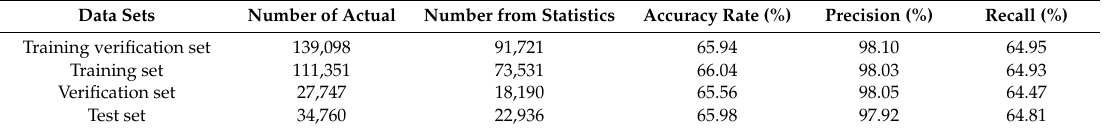
Table 1. YOLO general model tra ffi c statistics.